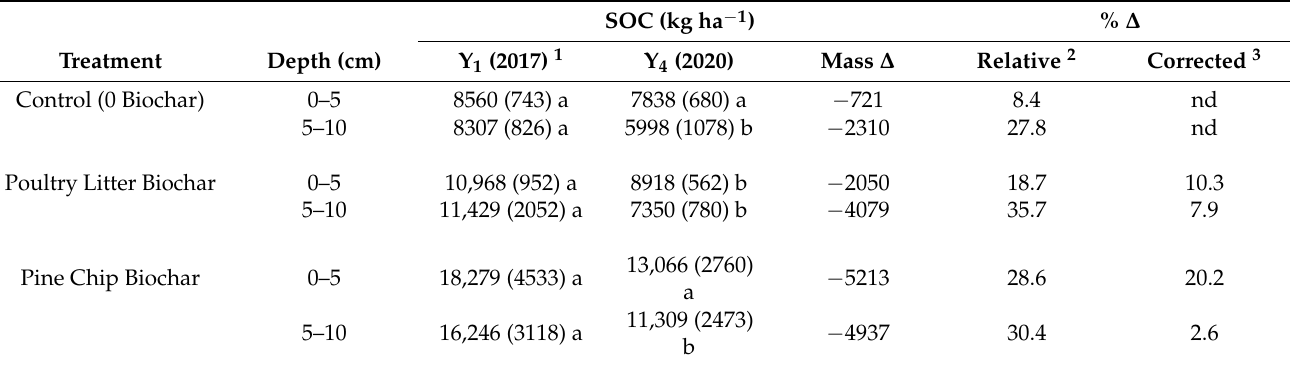
Table 6. Relative changes in mean soil organic carbon (SOC) contents measured in Controls and in plots treated with Poultry litter and Pine chip biochar (means from n = 4, standard deviations in parentheses, nd = not determined, ∆ = change). SOC (kg ha − 1 ) %